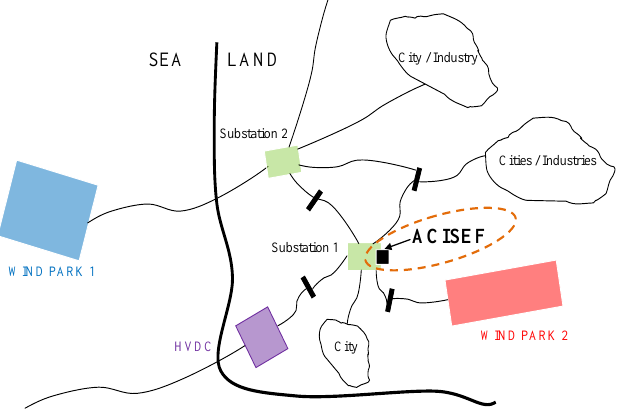
Figure 1. A possible AC grid with an abnormal low-order voltage harmonic level and the location of the active impedance at selective frequencies (ACISEF) at a sub-station.